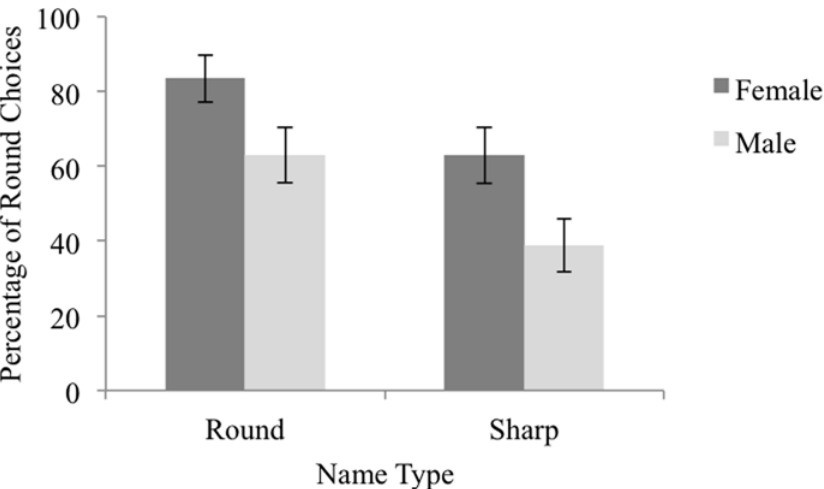
Fig 2. Percentage of Round Choices by Name Type and Gender in Experiment 1b. The percentage of trials on which participants selected the round silhouette as the best match for round-sounding and sharp- sounding, female and male names. Error bars reflect 95% confidence intervals computed using the method outlined by Cousineau [31] to remove between-subject